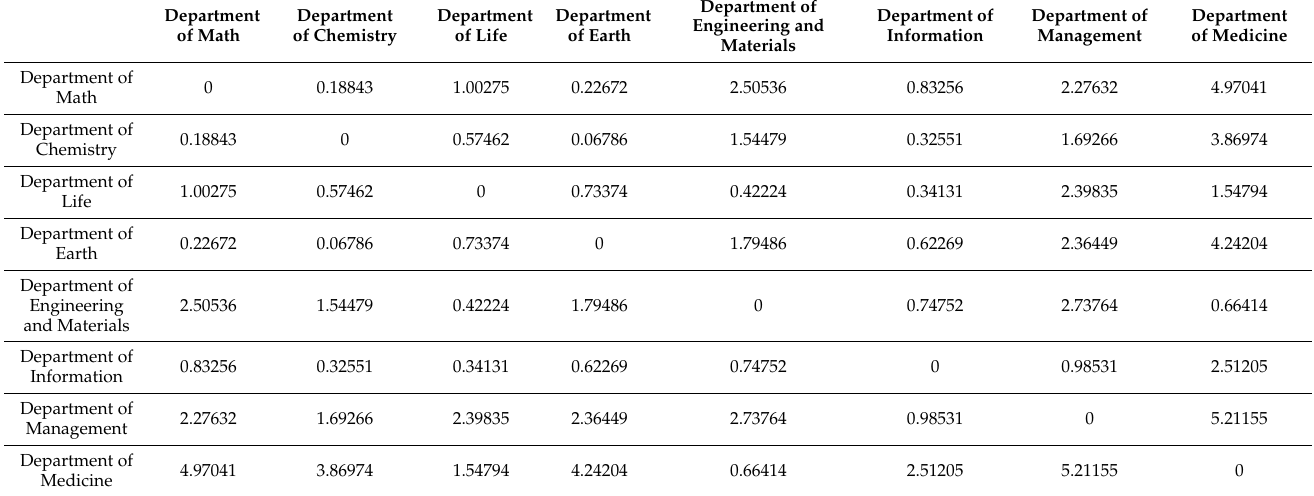
Table 2. Similarity calculation results between